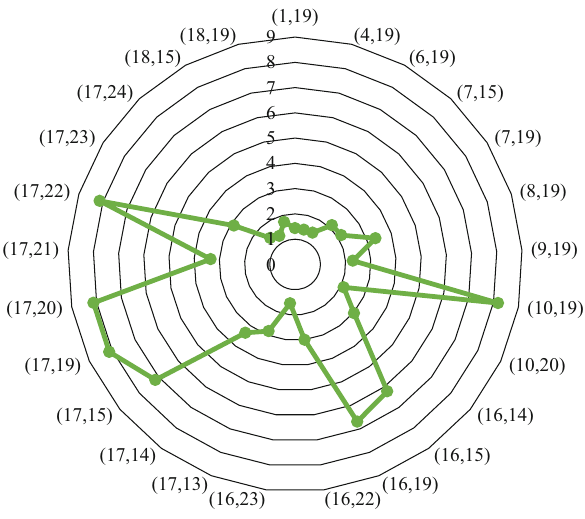
Fig. 8 Link flow sources